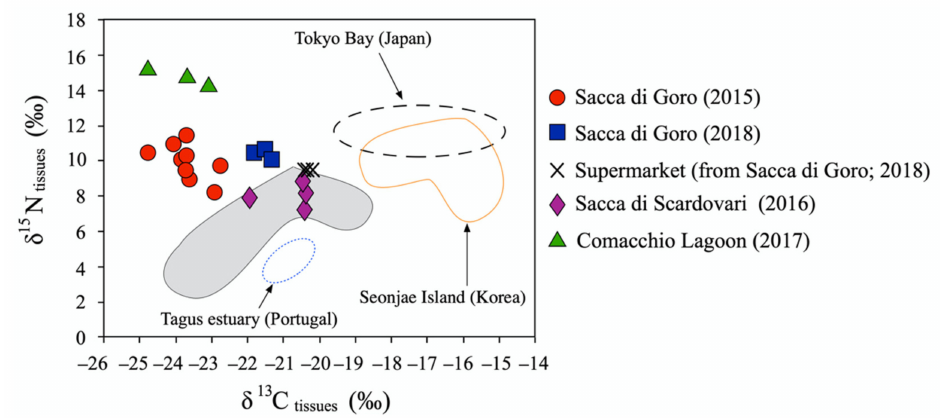
Figure 4. Comparison of carbon (C) and nitrogen (N) isotopic compositions of manila clam tissues from northern Adriatic lagoons with those from fisheries worldwide (Tagus estuary, Portugal [2]; Seonjae Island, Korea [52]; Tokyo Bay, Japan [56]). The grey area represents the C-N isotopic composition of Po suspended solids (data from